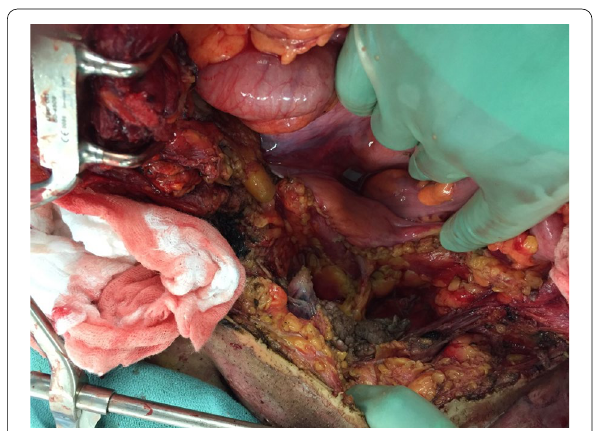
Fig. 5 Necrosis of rectus muscle secondary to electrical injury